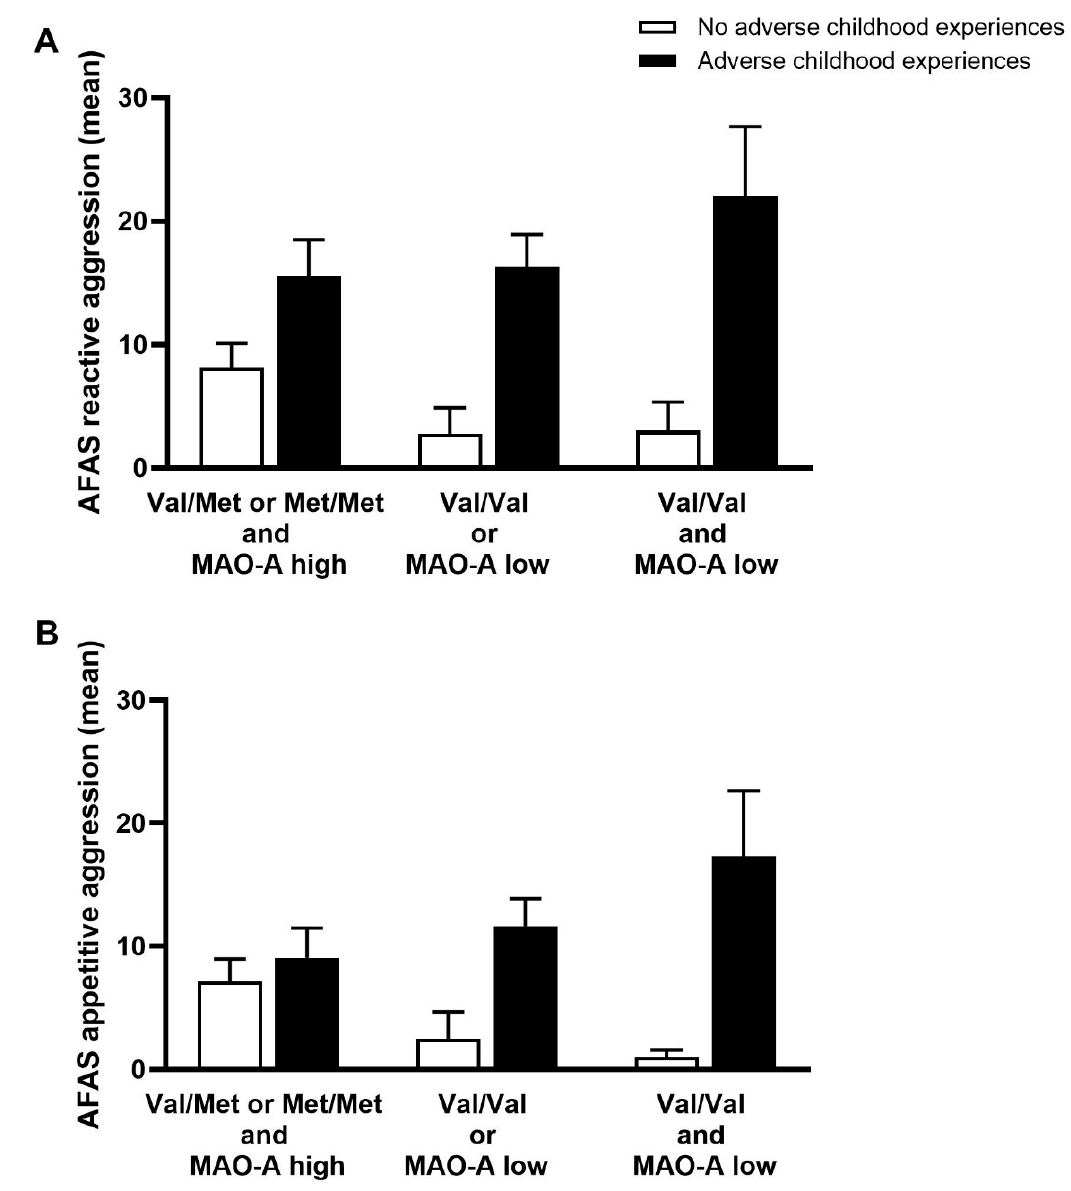
Figure 1. Generalized linear model. ( A ) generalized linear model revealed a significant main effect of both genotype and childhood experiences on reactive aggression; ( B ) generalized linear model for the influence of genotype and childhood experiences on appetitive aggression.